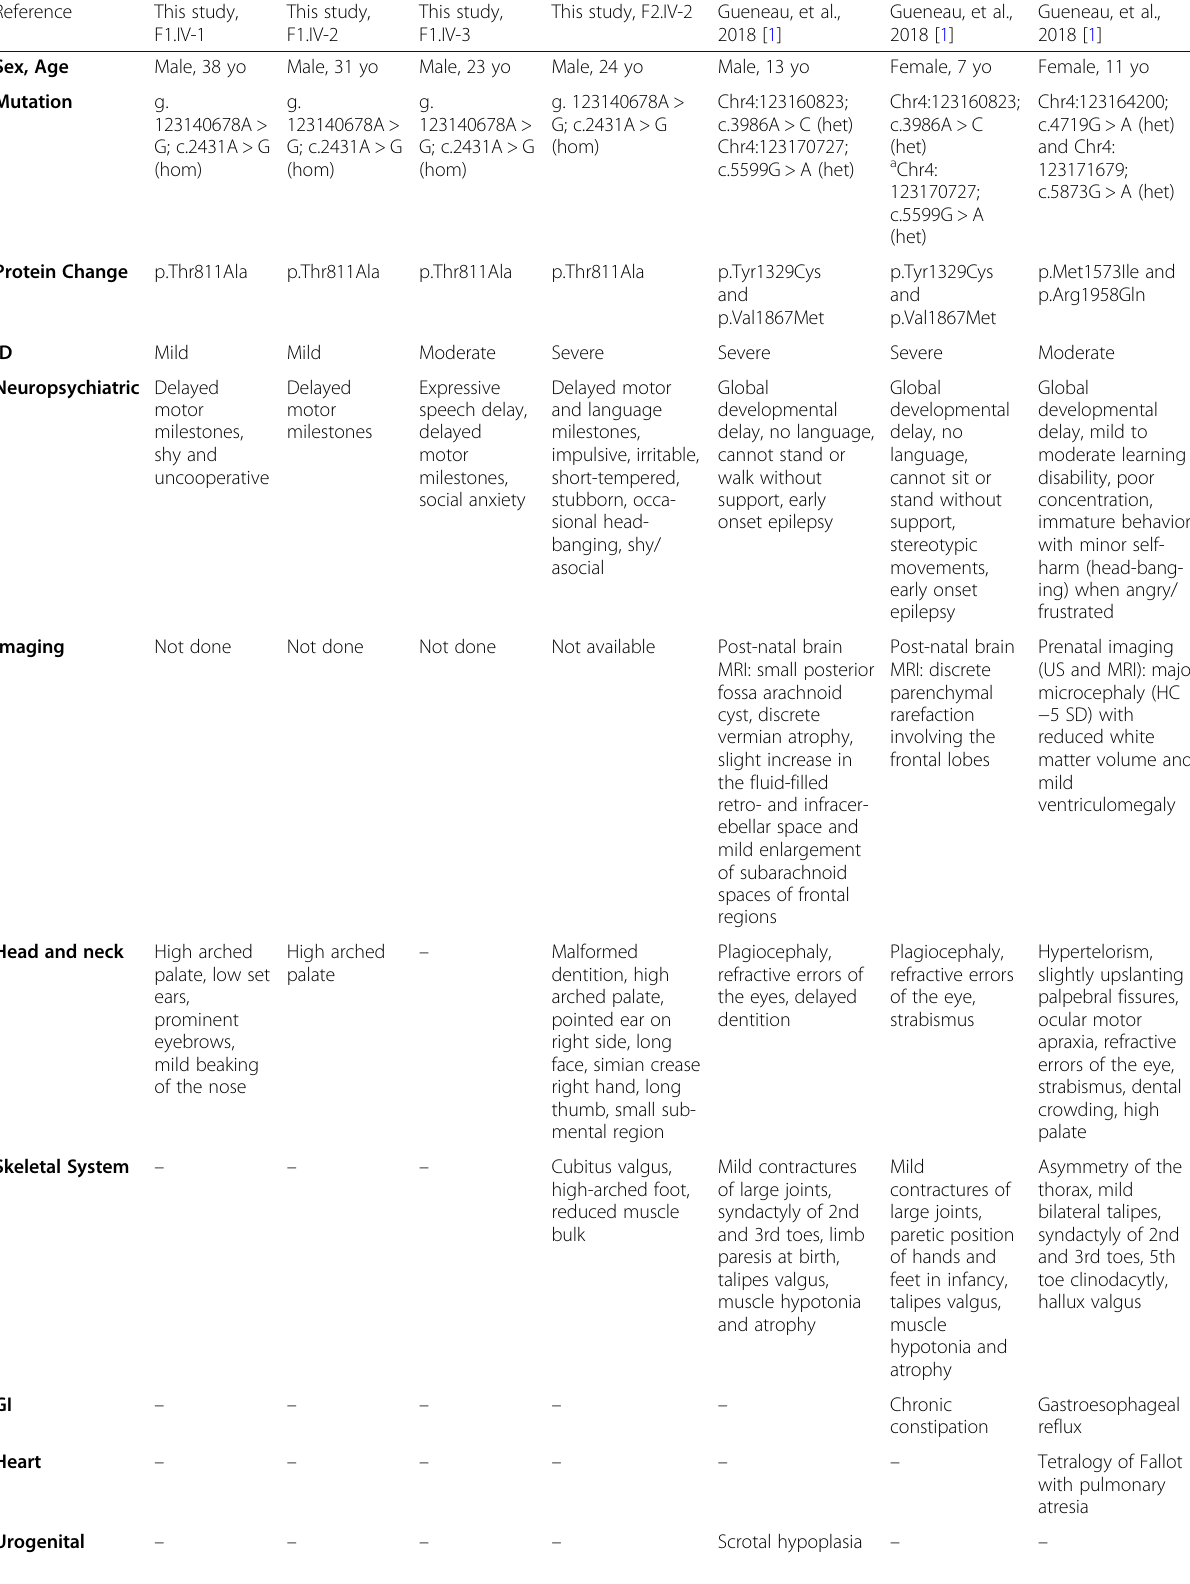
Table 2 Mutations and phenotypic features of surviving patients with KIAA1109 mutations